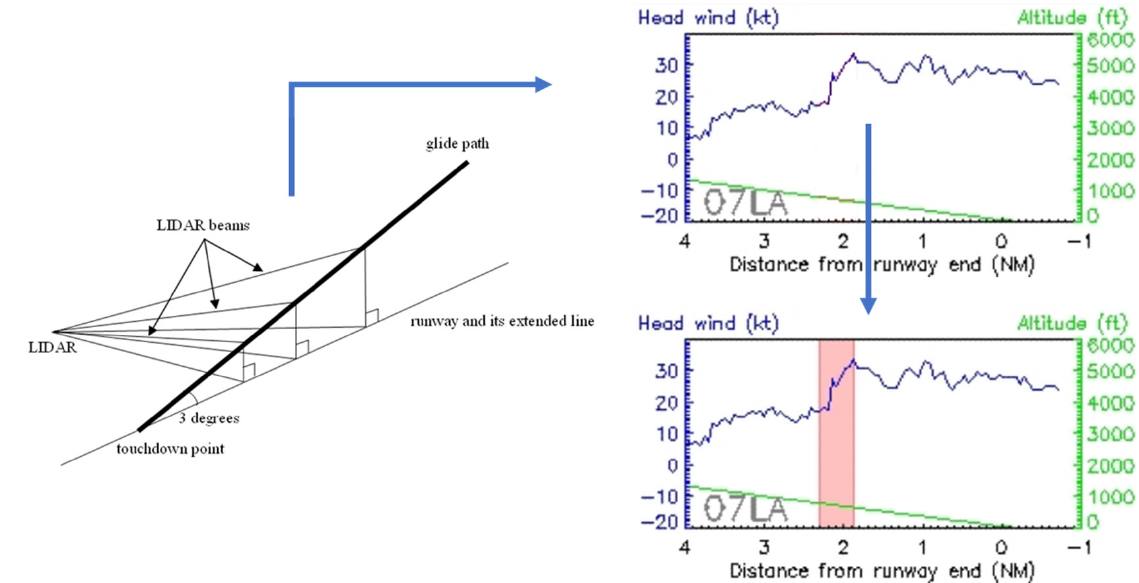
Figure 2. Schematic diagram of data processing in GLYGA algorithm.